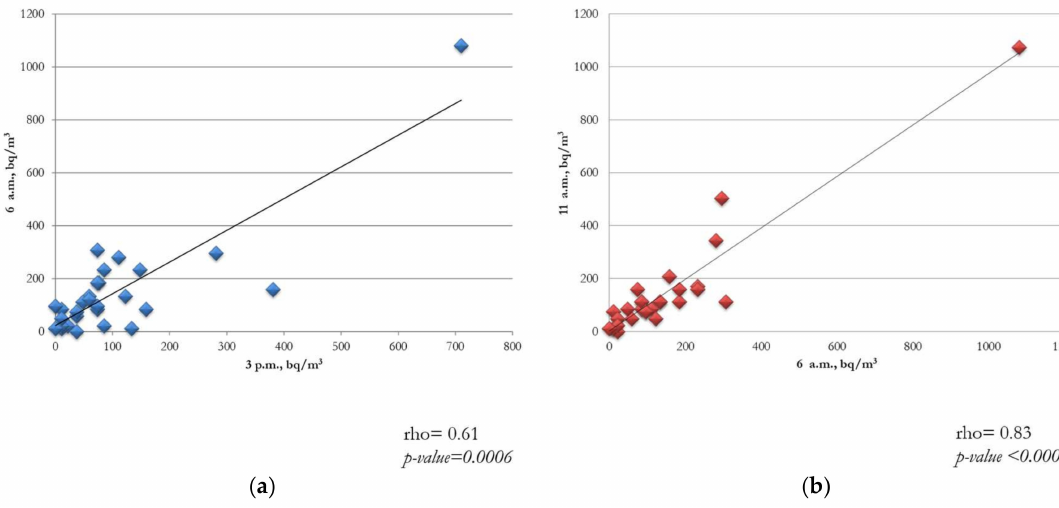
Figure 3. Correlation between radon concentrations and temporal periods ( a ) time-frame from 3:00 p.m. to 6:00 a.m.; and ( b ) from 6:00 a.m. to 11:00 a.m. Table 2. Spearman correlation analysis between environmental variables and radon concentration